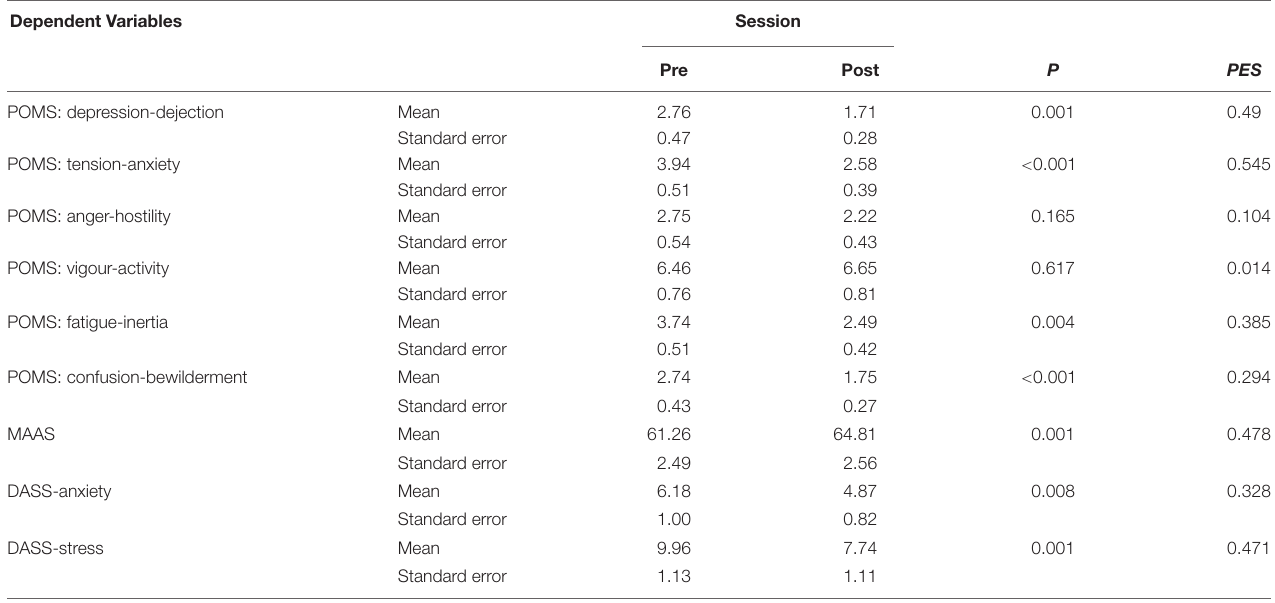
TABLE 3 | Mean, standard errors, and partial eta squared (PES) for the main effect of session for the POMS, MAAS and DASS questionnaires for the intervention group and control group. Dependent Variables Session